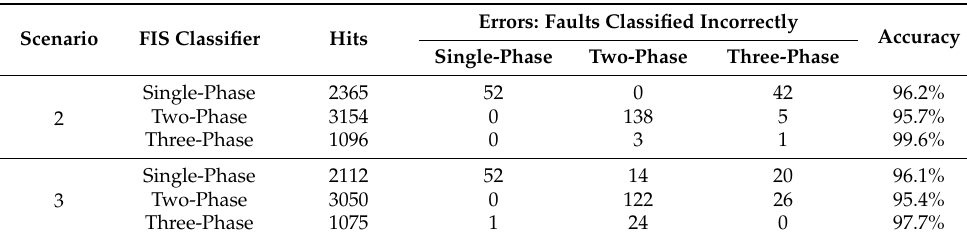
Table 10. FIS classifier performance for scenarios 2 and